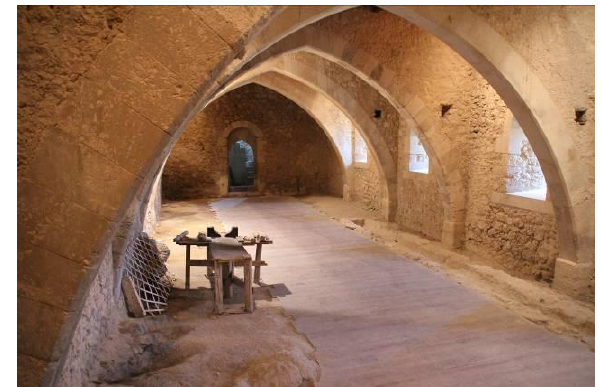
Figure 5. One of the main indoor environments of the castle